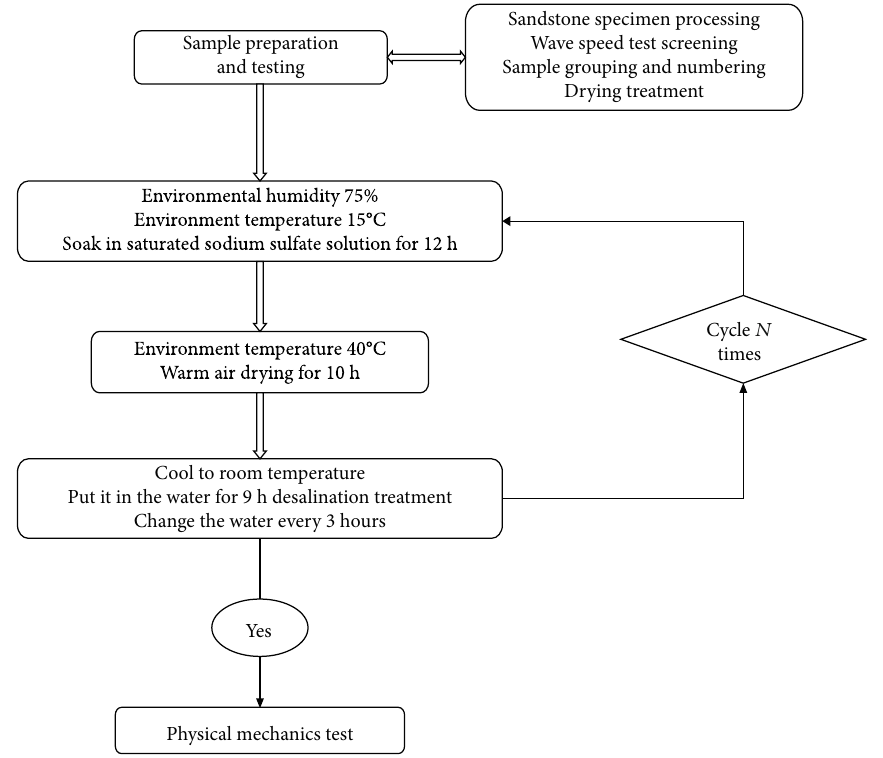
Figure 3: Erosion test operation fl